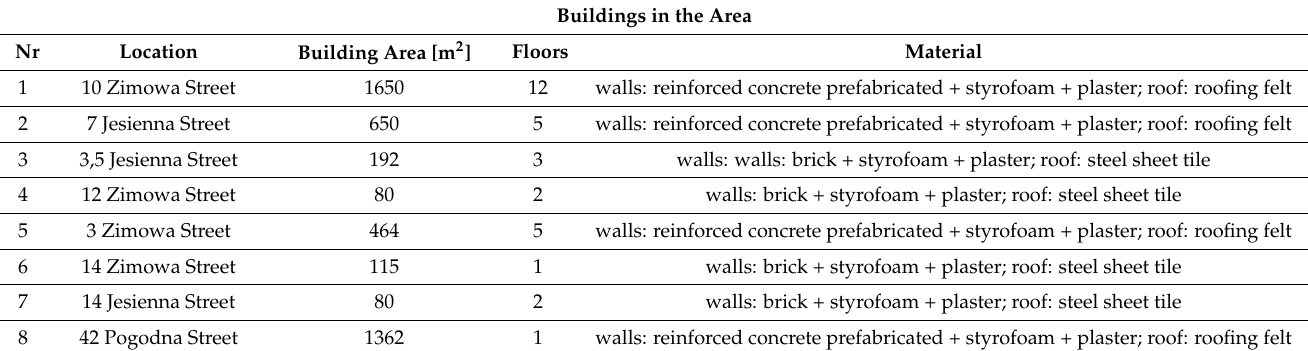
Table 1. Characteristics of buildings in the study